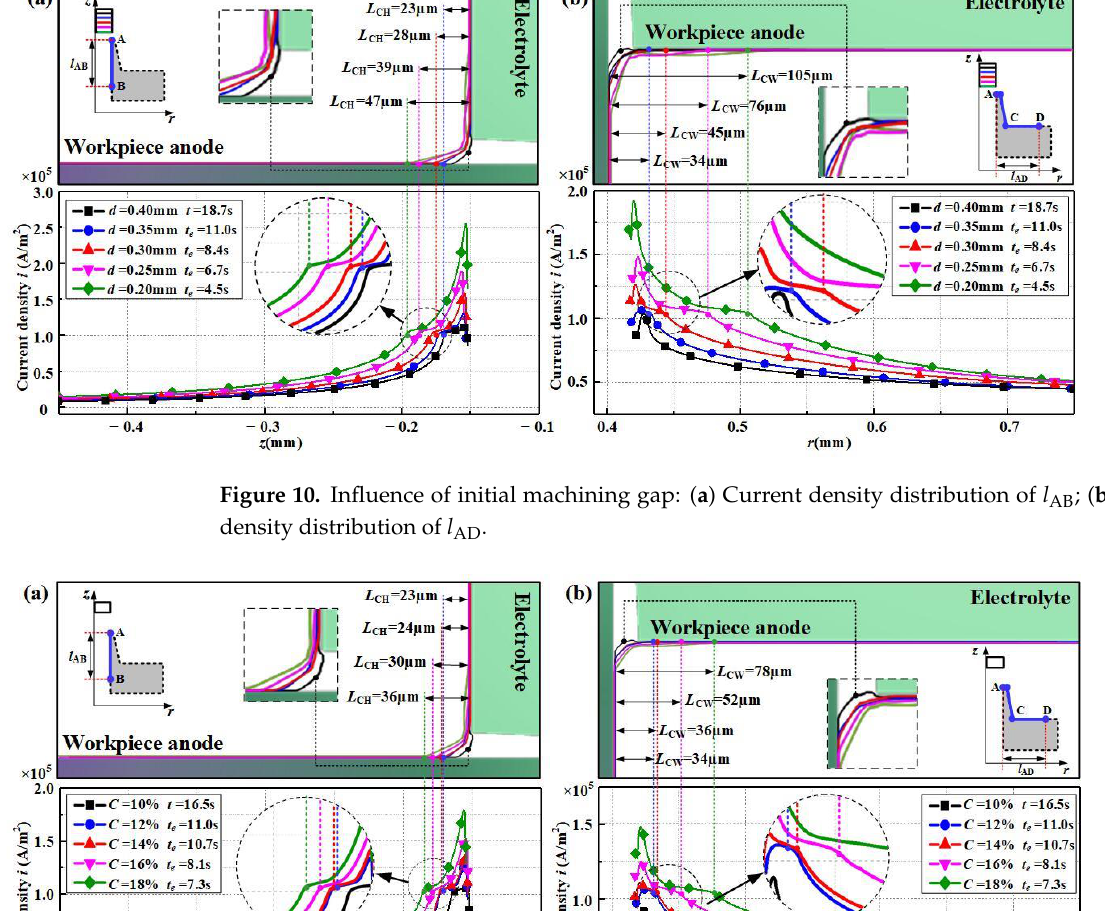
Figure 12. Influence of electrode radius: ( a ) Current density distribution of l AB ; ( b ) Current density distribution of l AD . 3.3. Comprehensive Comparison of Machining Effects The comprehensive comparison of machining effects under different parameters is shown in Figure 13. It can be seen from the figure that the machining voltage has the greatest influence on the chamfer width L CW and the chamfer height L CH under the simu- lation conditions, followed by the initial machining gap, electrolyte concentration, and